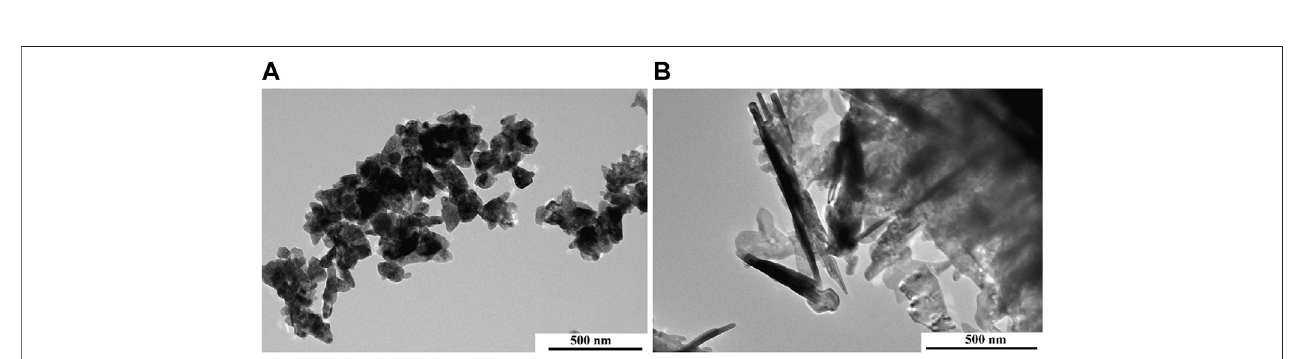
FIGURE 2 | TEM images of the ZnO samples: (A) — ZP 15, (B) — ZP 19.